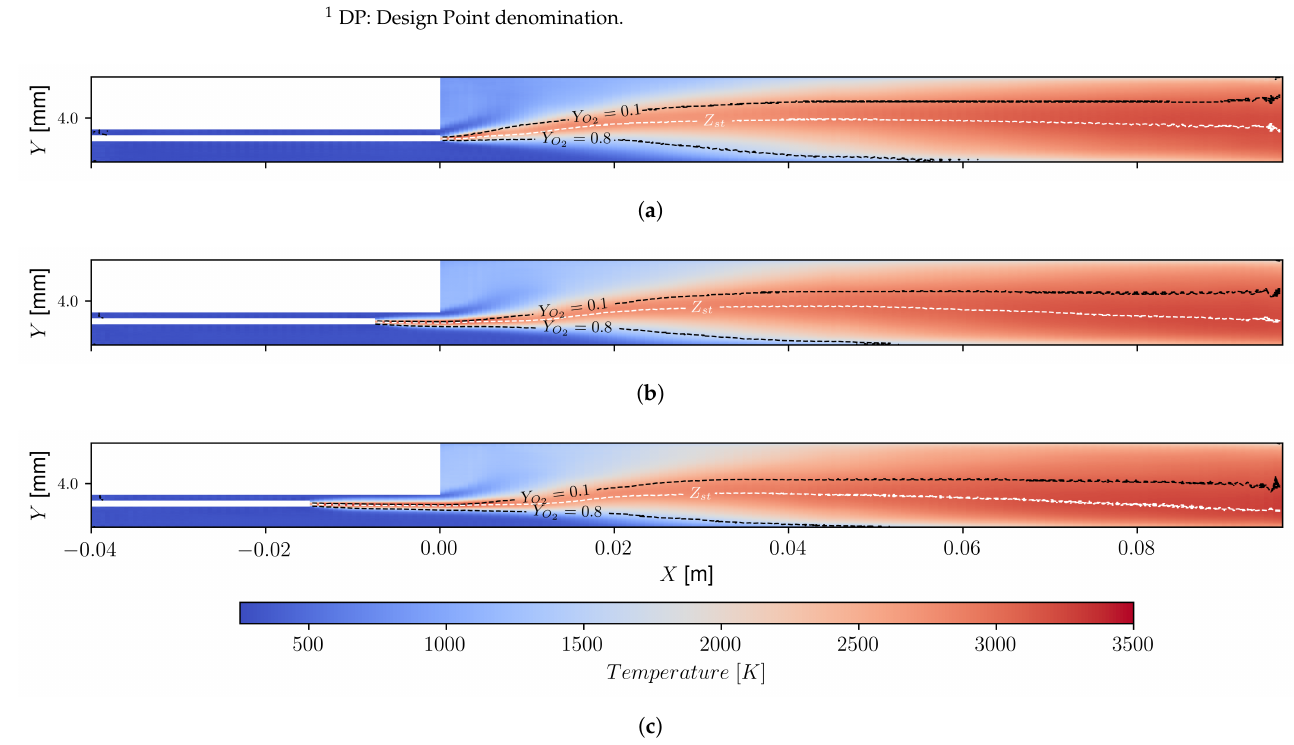
∈ [ 0.1, 0.8 ] , Ξ = Z st = 0.2 iso-lines have 2